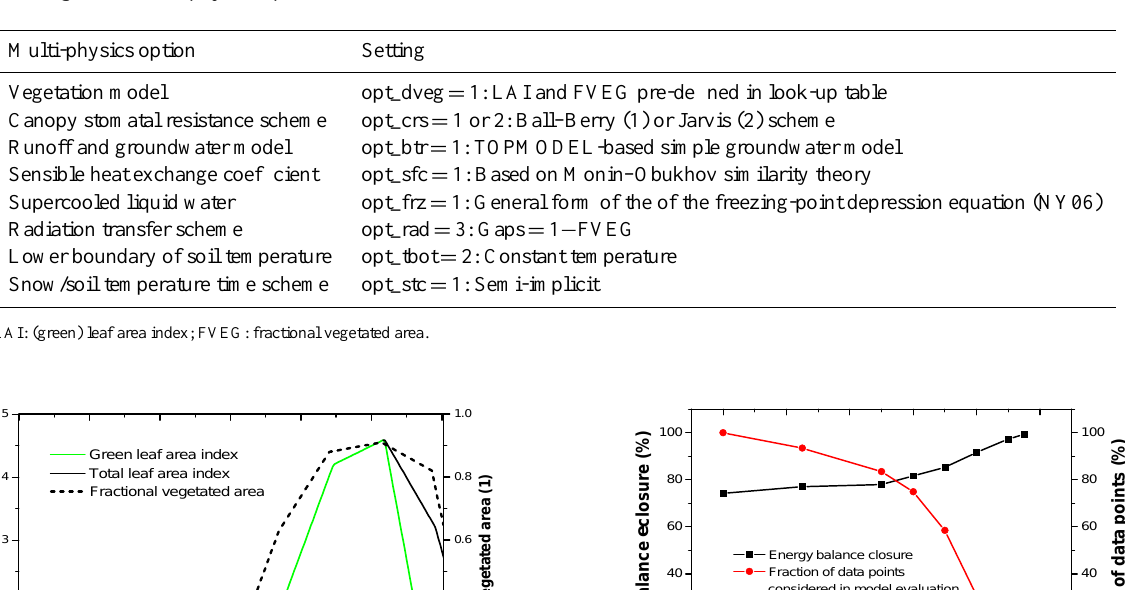
Table 2. Setting of the multi-physics options used in the NOAH-MP simulation.